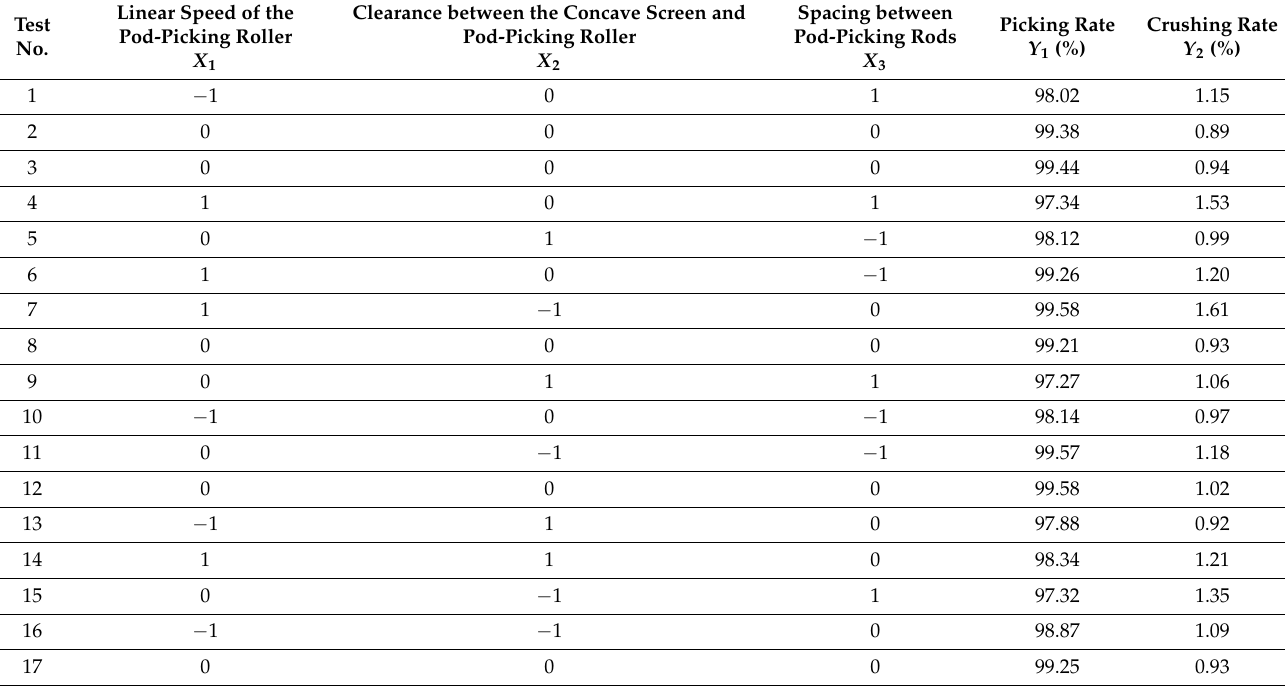
Table 3. Test scheme and